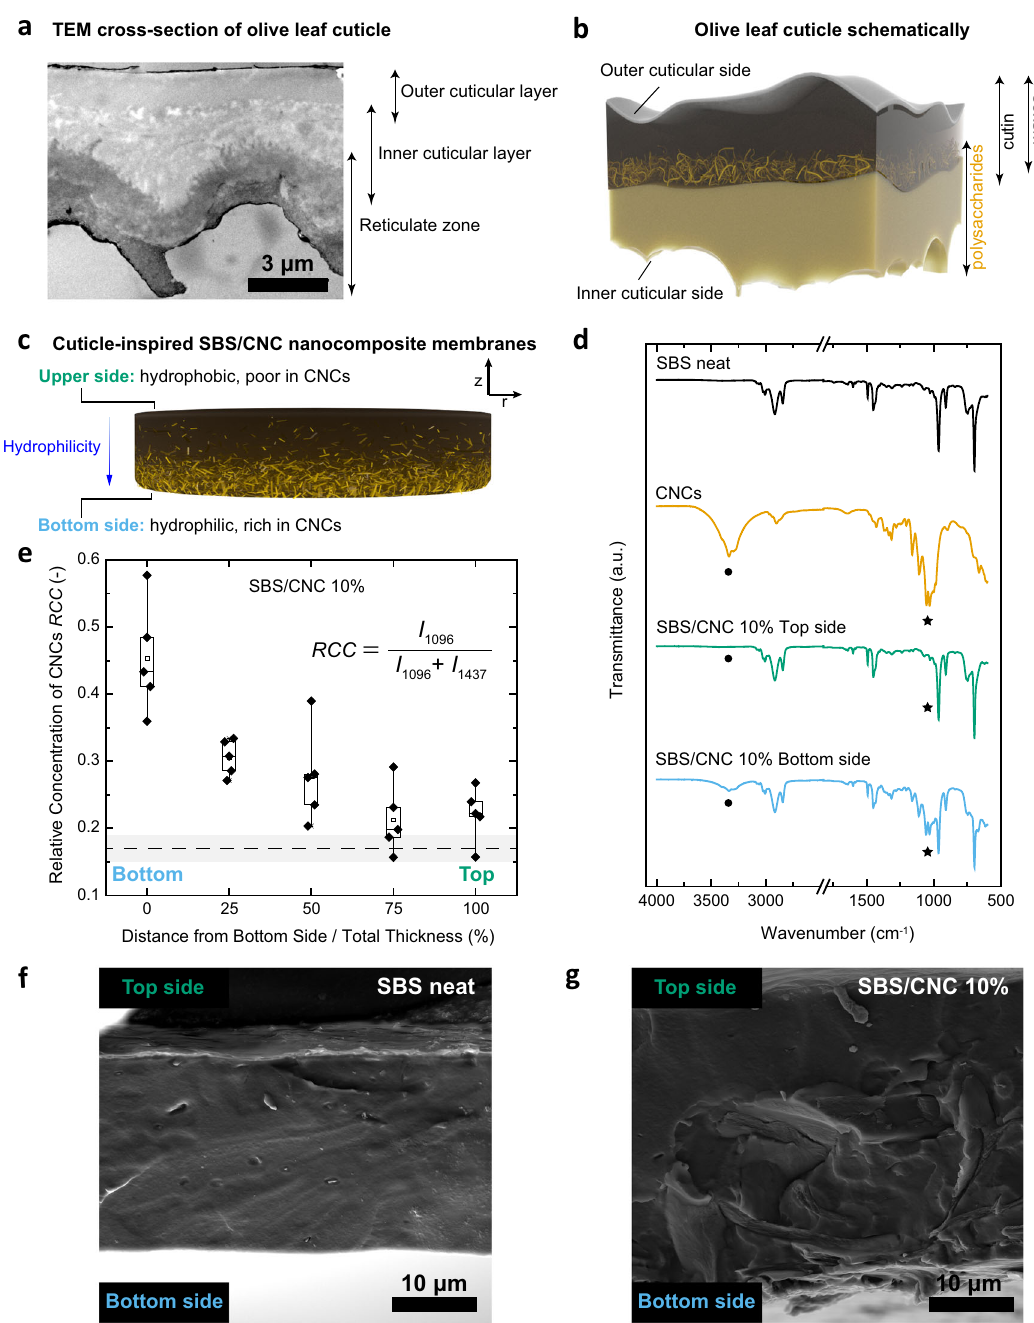
Fig. 1 Transversal composition gradients in olive cuticles and cuticle-inspired arti fi cial membranes. a Cross-section of an olive cuticle imaged with TEM. b , c Schematics (not to scale) of the graded architecture in the b olive cuticle and c SBS/CNC membranes. d ATR-IR spectra of SBS, CNCs, and an SBS/ CNC composite at the top and bottom side of the membrane. Signals marked with dot and star correspond to the CNCs ’ – OH and C – O/C – C vibrations. e Box plot showing the relative concentration of CNCs (RCC) as a function of transversal position ( n = 5 in each position) in a SBS/CNC membrane determined by Raman microscopy. The RCC was calculated from the intensities ( I ) of the CNCs ’ C – O (1096 cm − 1 ) and SBS ’ CH 2 (1437 cm − 1 ) vibration bands. Whiskers extend to min and max values, box edges show 25 – 75 percentiles, center line represents median, and hollow square represents mean. The dashed line and gray band are the mean ± s.d. ( n = 3 in each position) of the RCC of the SBS reference. f , g SEM images of the cross-section of f SBS and g SBS/CNC membranes. All composite membranes shown here were ~33 μ m and contained 10 wt%